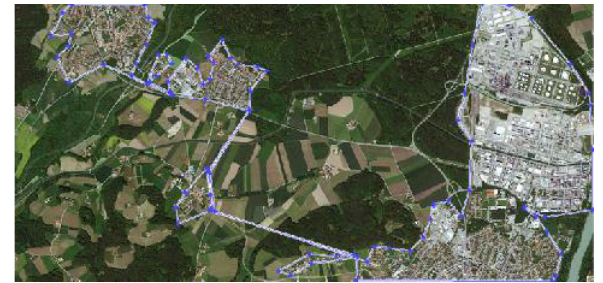
Figure 9. ROI of urban manual outline drawing.